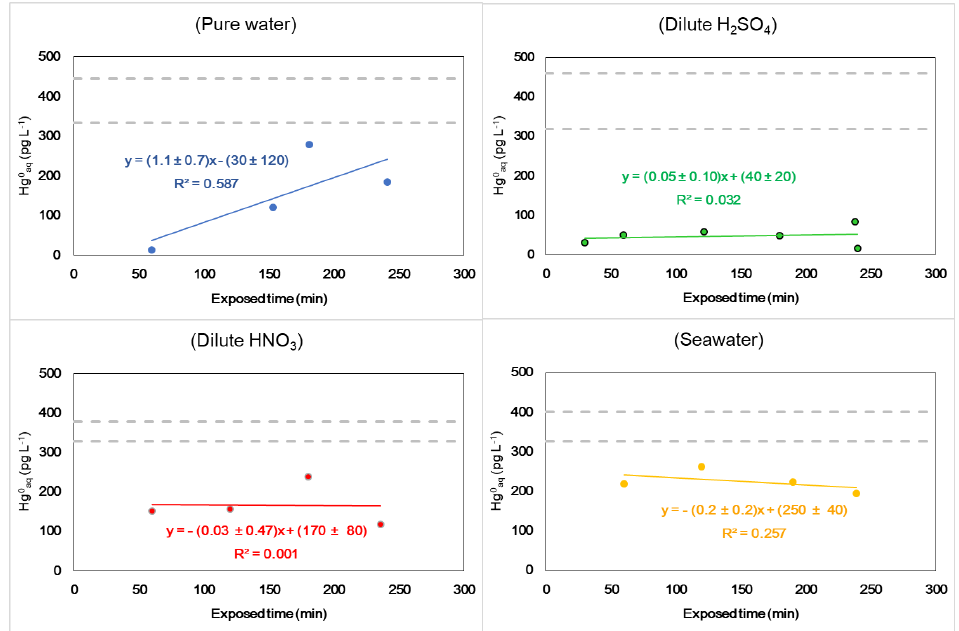
Figure 3. Concentration of dissolved elemental mercury (Hg 0 aq ) in the variety of uptake solutions as a function of the exposure time to the standard gas of 101–153 ng m − 3 gaseous elemental mercury. The gray horizontal lines shown in each plot are for the lowest and highest equilibrated concentrations of Hg 0 aq , according to Henry’s law, estimated with the use of the temperature and GEM concentrations provided in Table 2 and Henry’s constants in the literature (7). Linear regressions are also shown in the figures, and the uncertainties shown for each regression are standard errors.